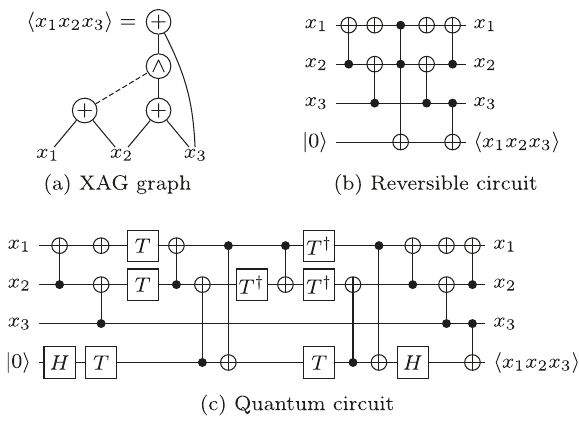
Fig. 1 The three steps perfomed to compile an XAG representing the majority-of-three function. a Speci fi cation; b corresponding reversible circuit; c corresponding quantum